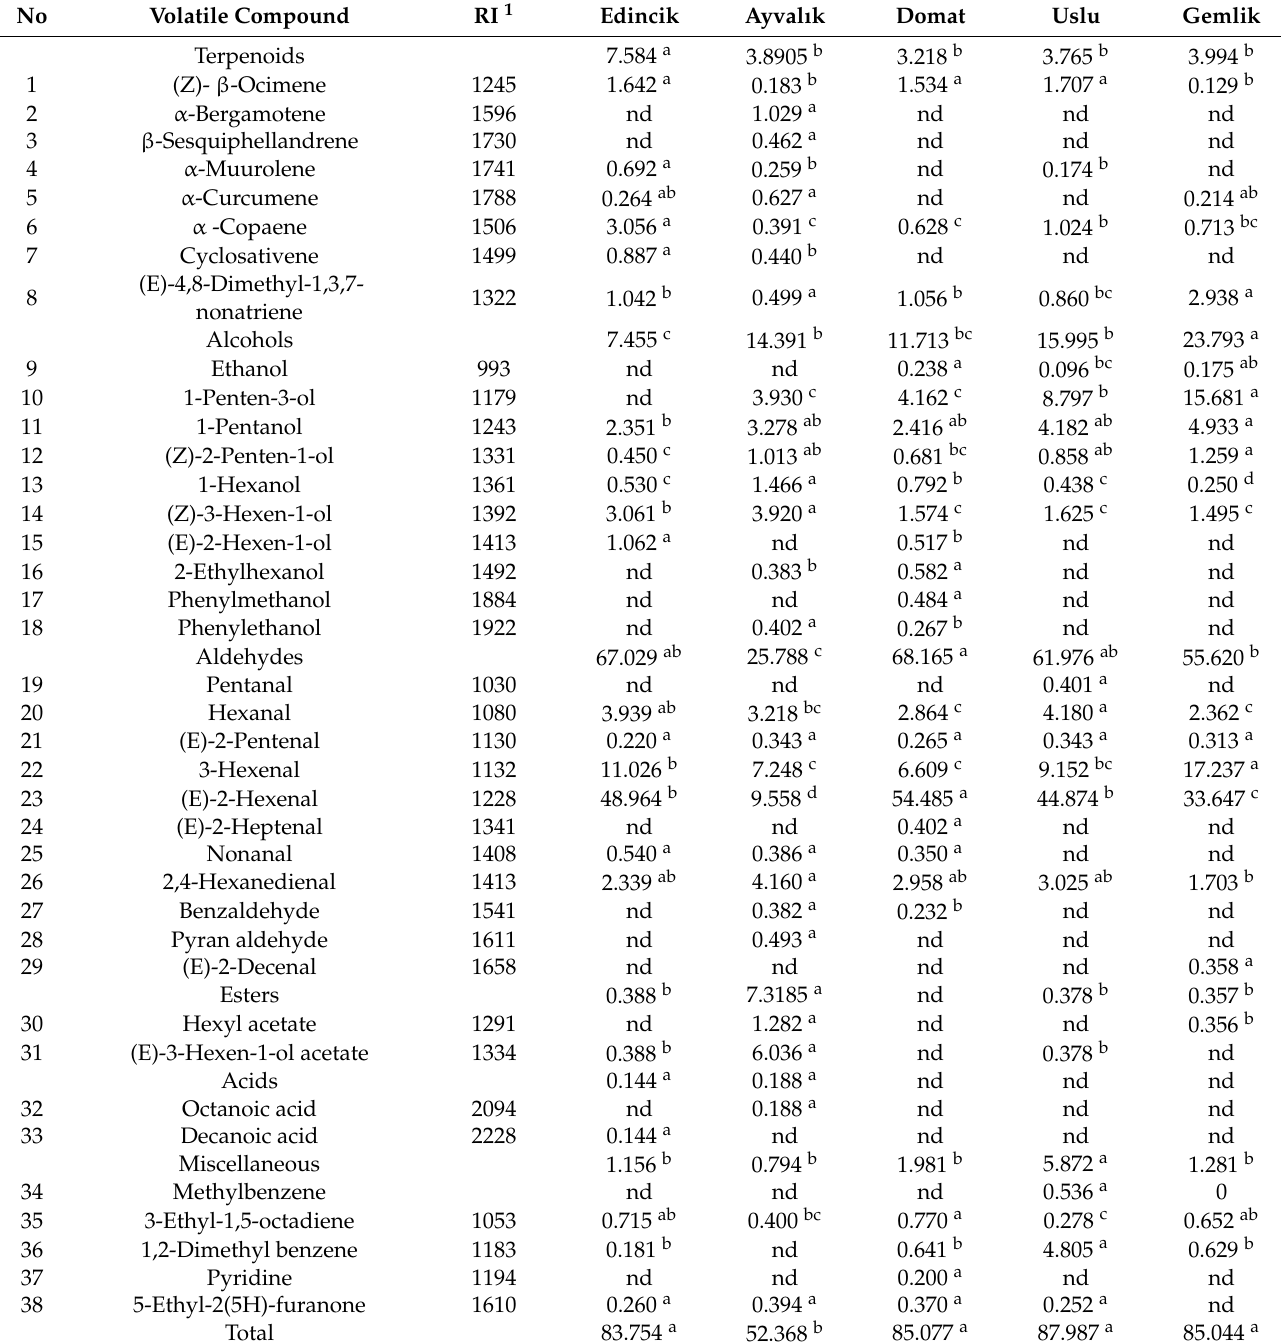
Table 4. Composition of volatile compounds (mg · kg − 1 ) in EVOOs from five Turkish olive